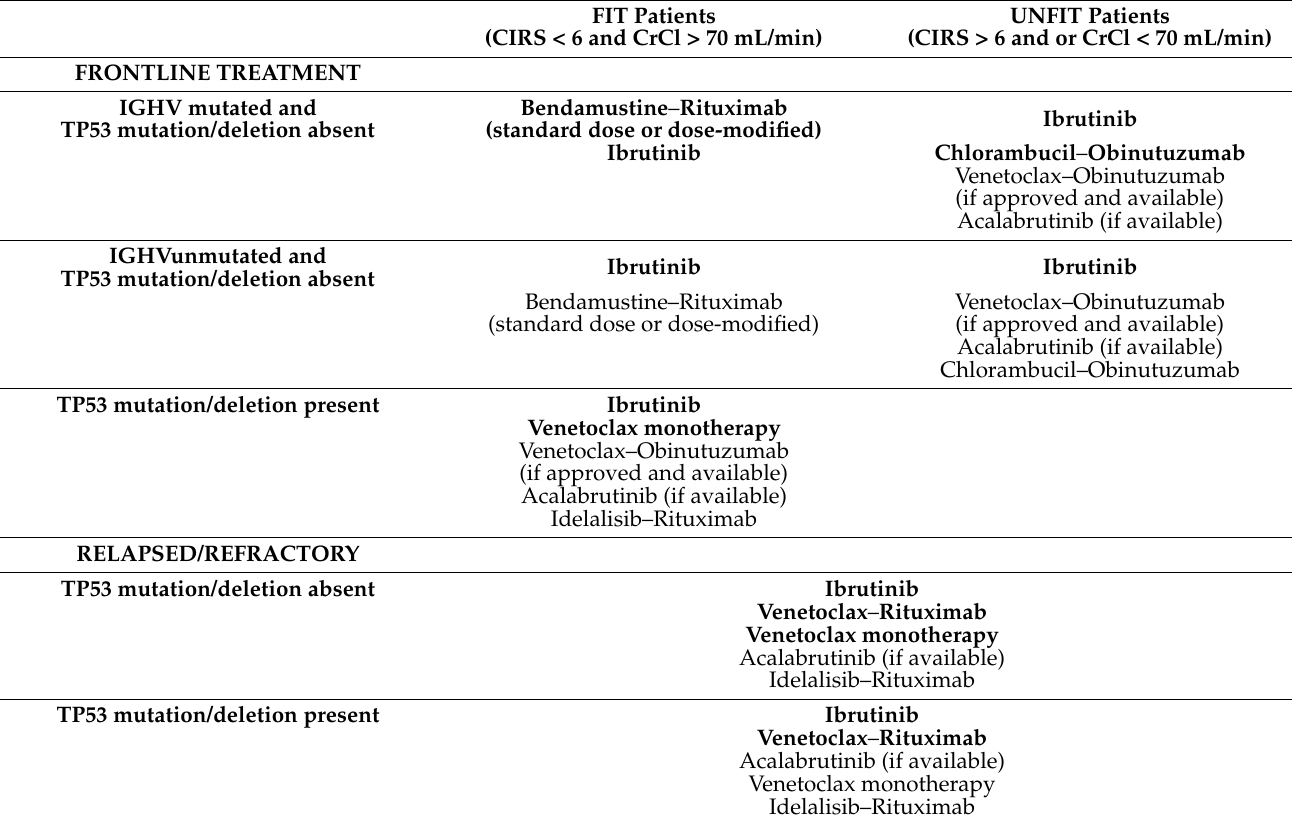
Table 3. Current treatment recommendations in elderly (older than 65 years) patients with CLL. FIT Patients (CIRS < 6 and CrCl > 70